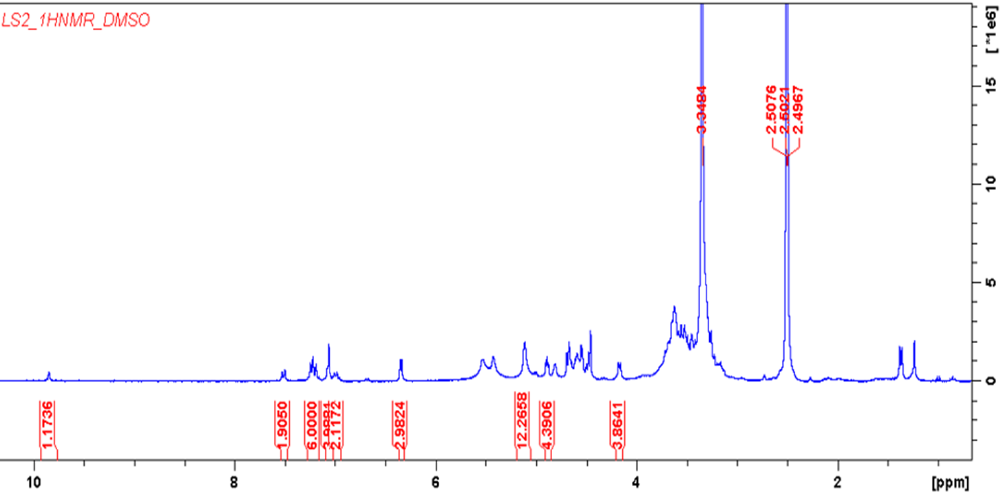
Figure 3. The 1 H NMR Spectra for the confirmation of lovastatin. NMR spectra suggests the following peaks on (LS 2 ); 985 (1H, S, COOH), 7.51 (2H, d, 2 × CH, J = 5.5 mHz), 7.22 (6H, m, 3 × CH 2 ), 7.06 (4H, S, 4 × CH), 6.99 (2H, m, 1 × CH 2 ), 6.34 (3H, d, J = 3.34 mHz), 5.11 (12H, d, 4 × CH 3 ), 4.90 (4H, t), 4.17 (4H, d, J = 3.6 mHz).